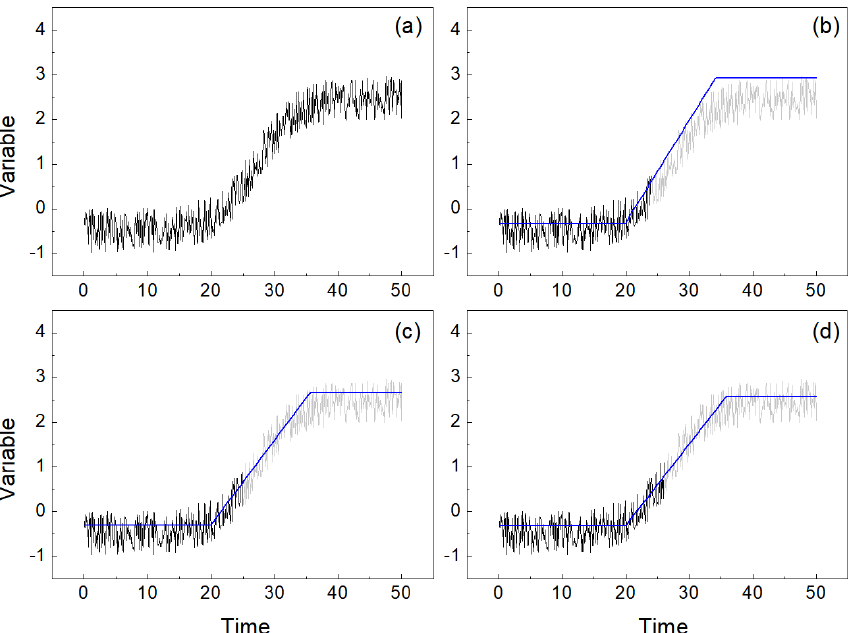
Figure 5. The ideal time sequence constructed by the logistic model and random numbers. The x axis represents time, and the y axis represents variable x (cid:48) t . (a) Completed transition process with 500 moments, uncompleted transition processes (the gray lines) and their prediction results (the blue lines) with (b) 240 moments, (c) 250 moments and (d) 260 moments. The light gray lines are the original entire ideal time sequences.